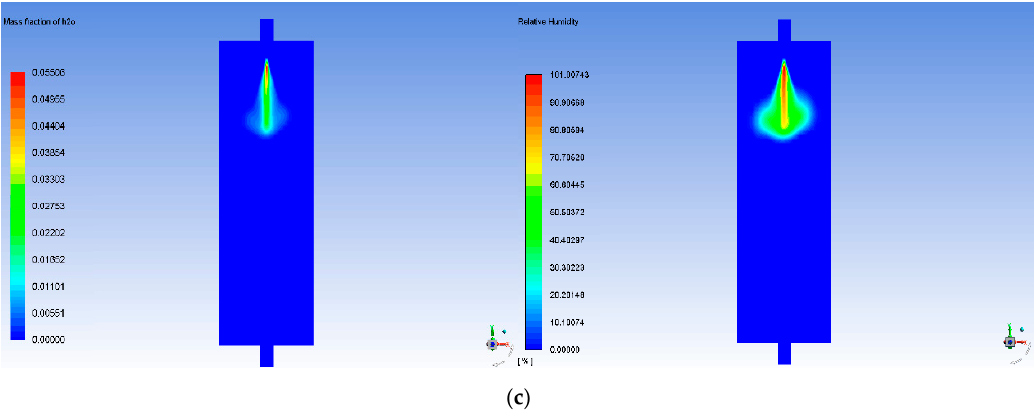
Figure 5. Water vapor mass fraction and relative humidity at the outlet of humidifier at different temperatures: ( a ) The temperature is 50 ◦ C; ( b ) the temperature is 60 ◦ C; ( c ) the temperature is 70 ◦ C.